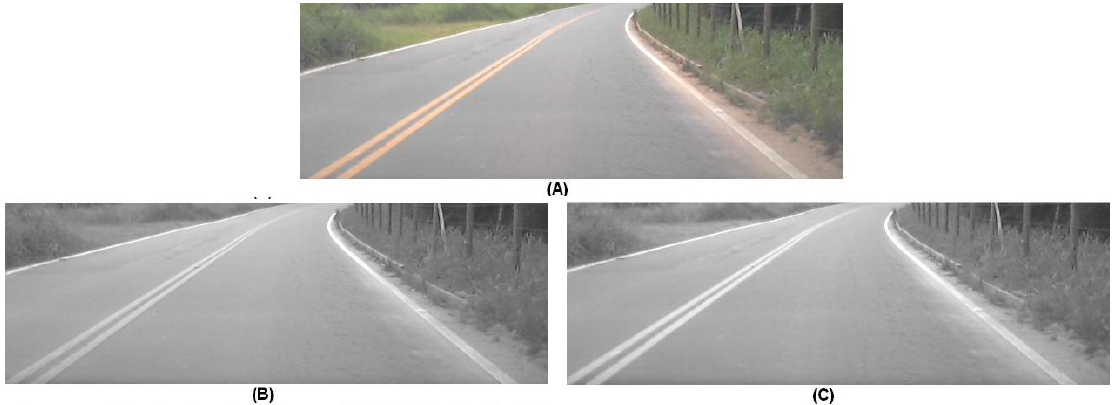
Figure 7. Conversion to gray-scale: ( A ) original image. ( B ) standard conversion. ( C ) proposed